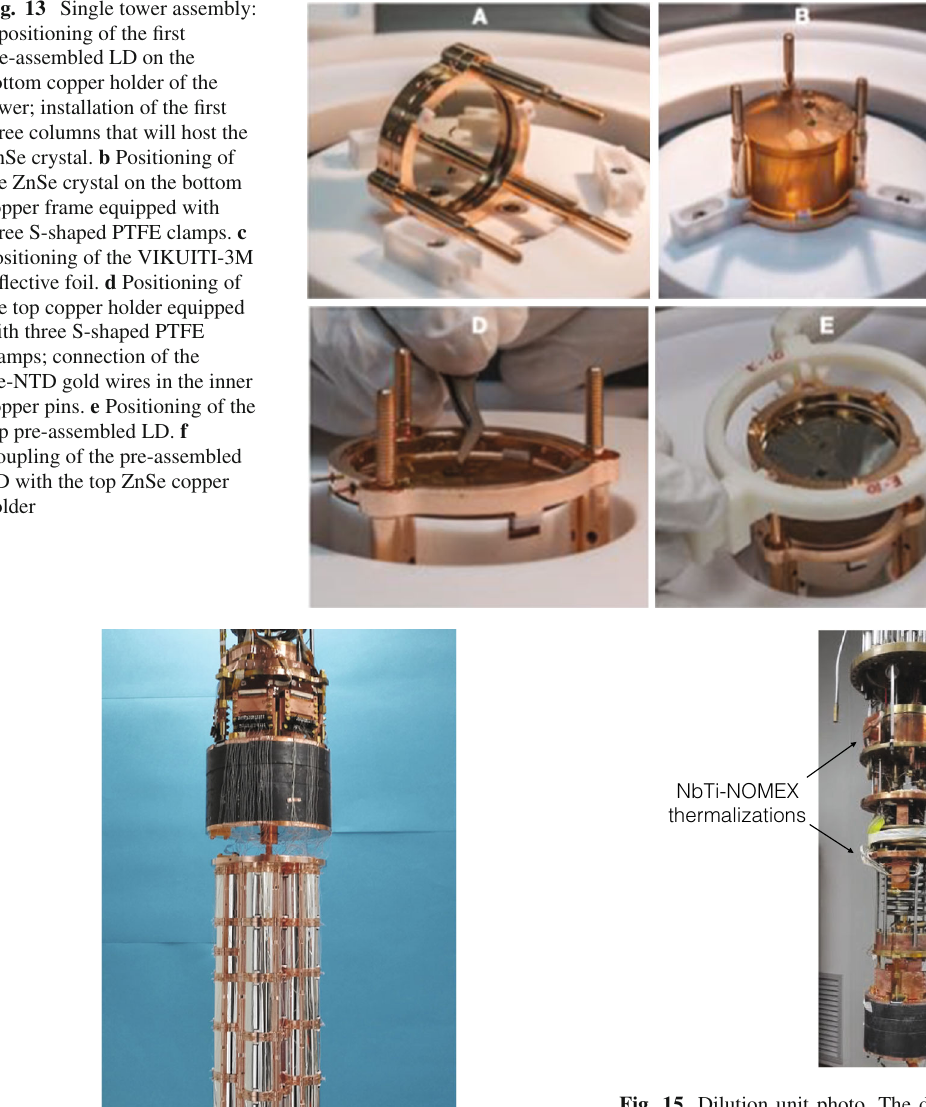
Fig. 14 CUPID-0 detector installed on the cryogenic system, just below the 10 cm thick Roman Pb shielding